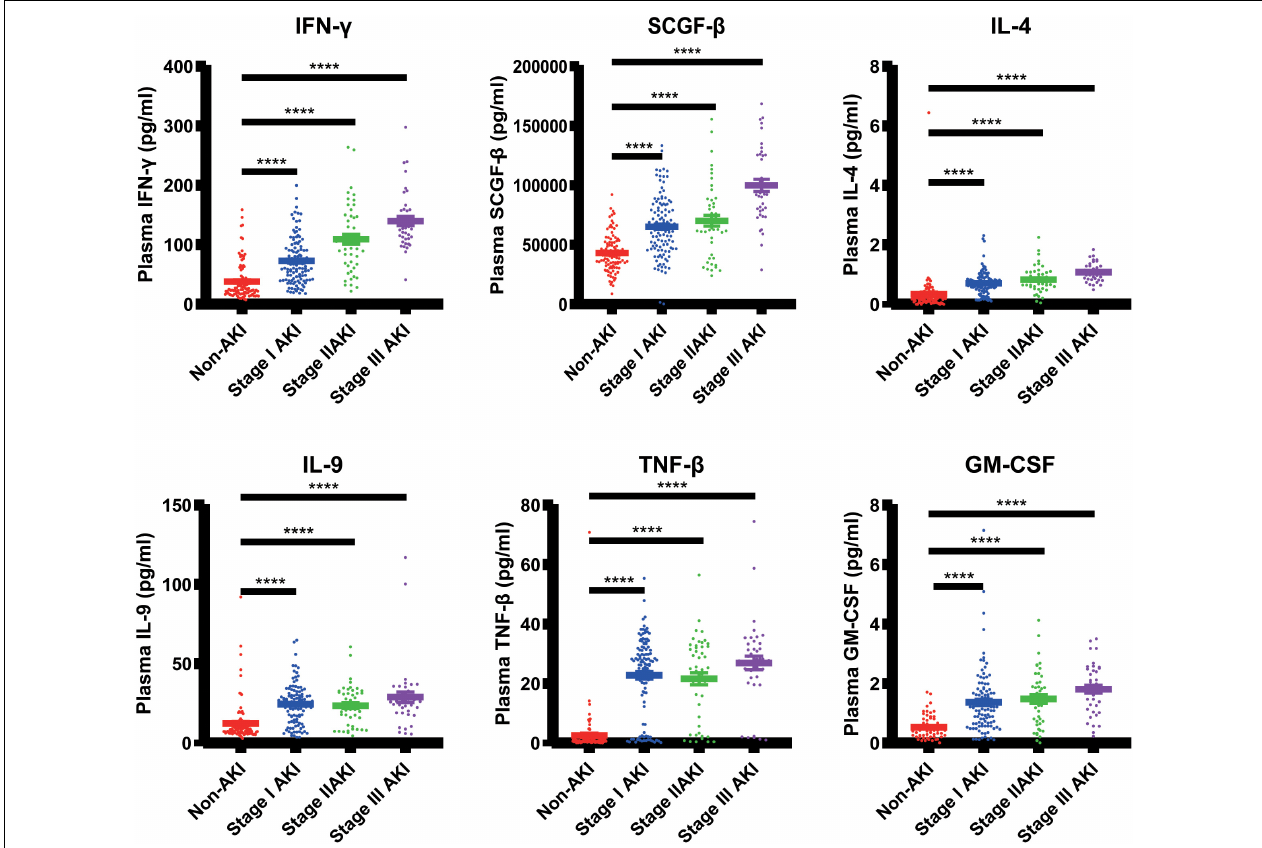
FIGURE 5 | The significantly different cytokines among the non-AKI, Stage I AKI, Stage II AKI, and Stage III AKI groups. **** p < 0.00001.